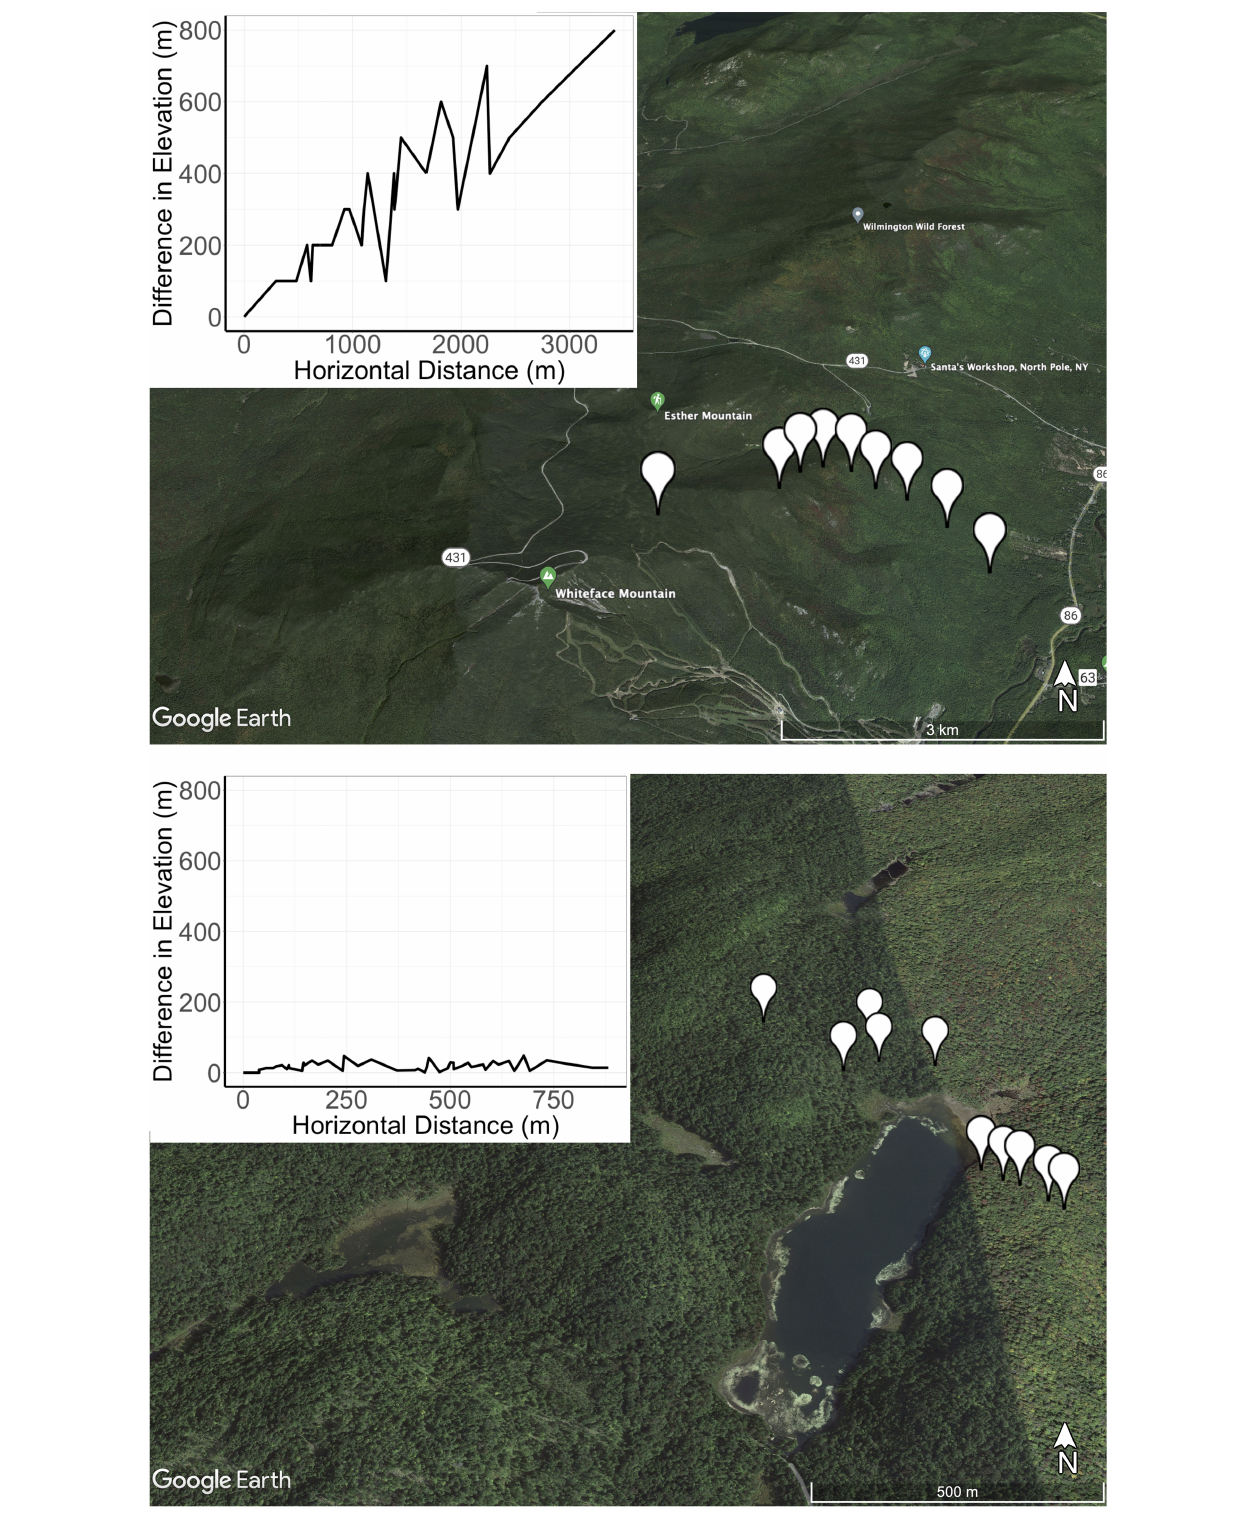
FIGURE 1 | The sites at Whiteface Mountain (WM; top ) span more than 1,000 m elevation while those at Woods Lake ( bottom ) span less than 100 m elevation. The topographical profile is provided in the inset. Horizontal distances (X-axis) are measured as geodesic distance or the shortest distance between the GPS coordinates of each site while the Y-axis represents difference in elevation relevant to the base elevation at